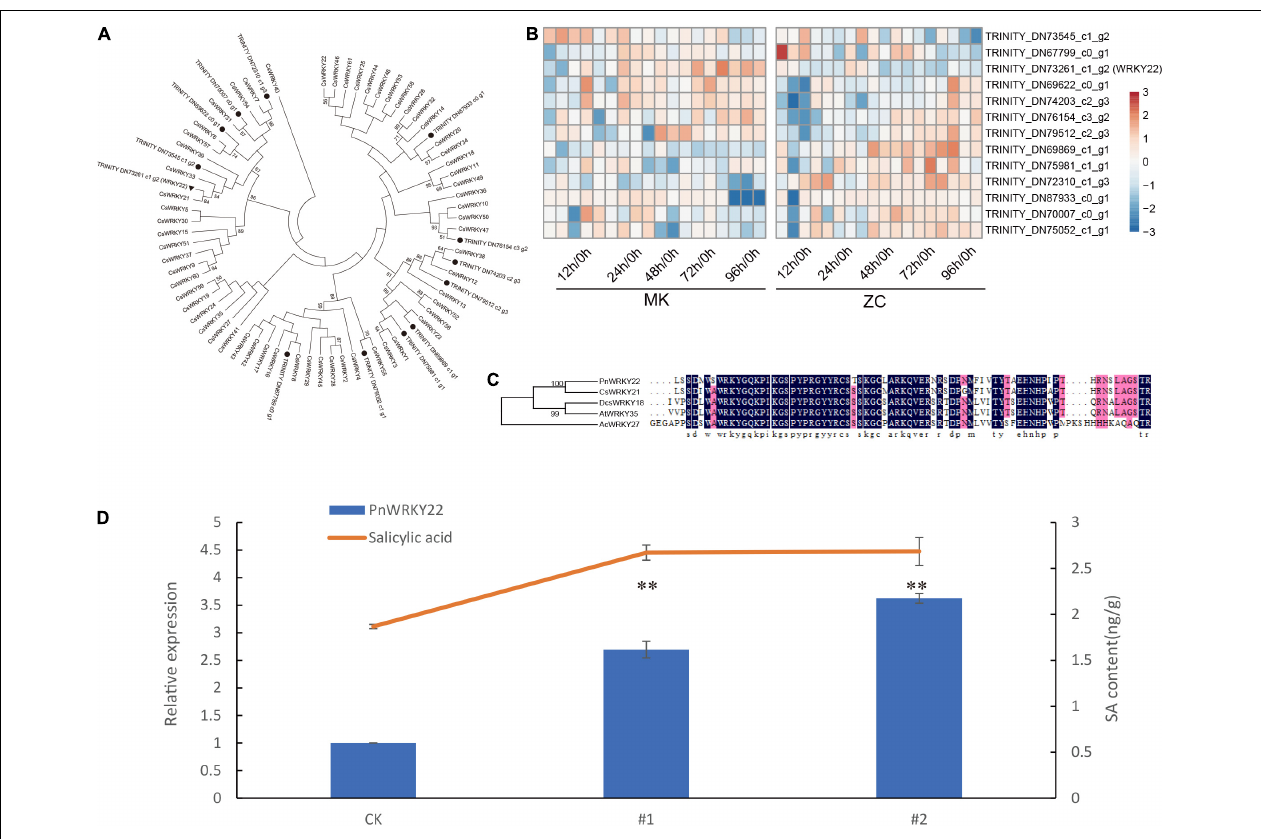
FIGURE 6 | Characterization and functional analysis of PnWRKY22 . (A) Phylogenetic tree analysis of WRKYs identified in P. notoginseng and cucumber. (B) Expressions of P. notoginseng WRKYs in two genotypes during infection. (C) Sequence alignment of PnWRKY22 and other WRKY. (D) Relative expression levels of PnWRKY22 and SA content in WT and 2 OE lines. Data are expressed as the means ± SD, n = 3. The asterisks denote significant differences according to one-way analysis of variance (ANOVA) ( ∗∗ P <